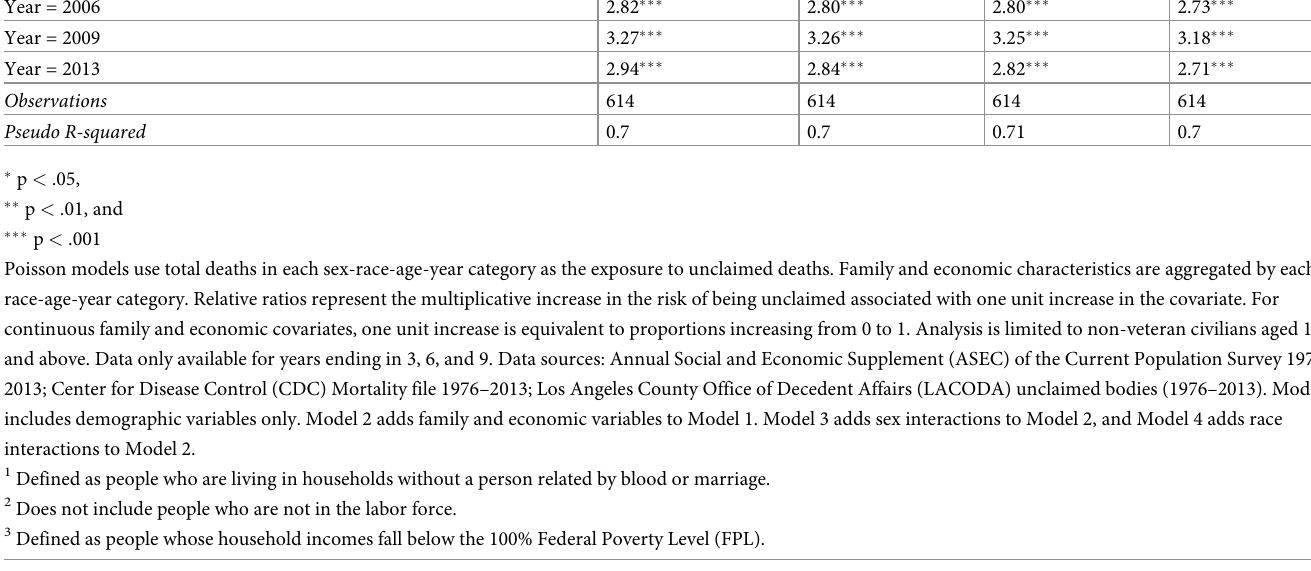
rates of unclaimed bodies, poverty at the aggregate level is not. Model 3’s sex interactions reveal significant sex differences in the association between family isolation and unclaimed deaths. Proportion never married is significantly associated with higher rates of unclaimed deaths among women but not men, and proportion divorced/separated is associated with higher rates of unclaimed deaths among men but not women. While the relationship between unemployment and unclaimed deaths were not significantly difference between men and women, living in poverty was associated with higher rates of unclaimed deaths for women. Model 4 explore race differences in the association between family isolation, economic hard- ship, and unclaimed deaths. The association between measures of family isolation and unclaimed deaths were not as strong among African American as they were among whites. Unemployment had no significant race interactions, but living in poverty had a significantly weaker link to unclaimed deaths among the ‘other’ race group. Table 4 examines migration and immigration characteristics in addition to the